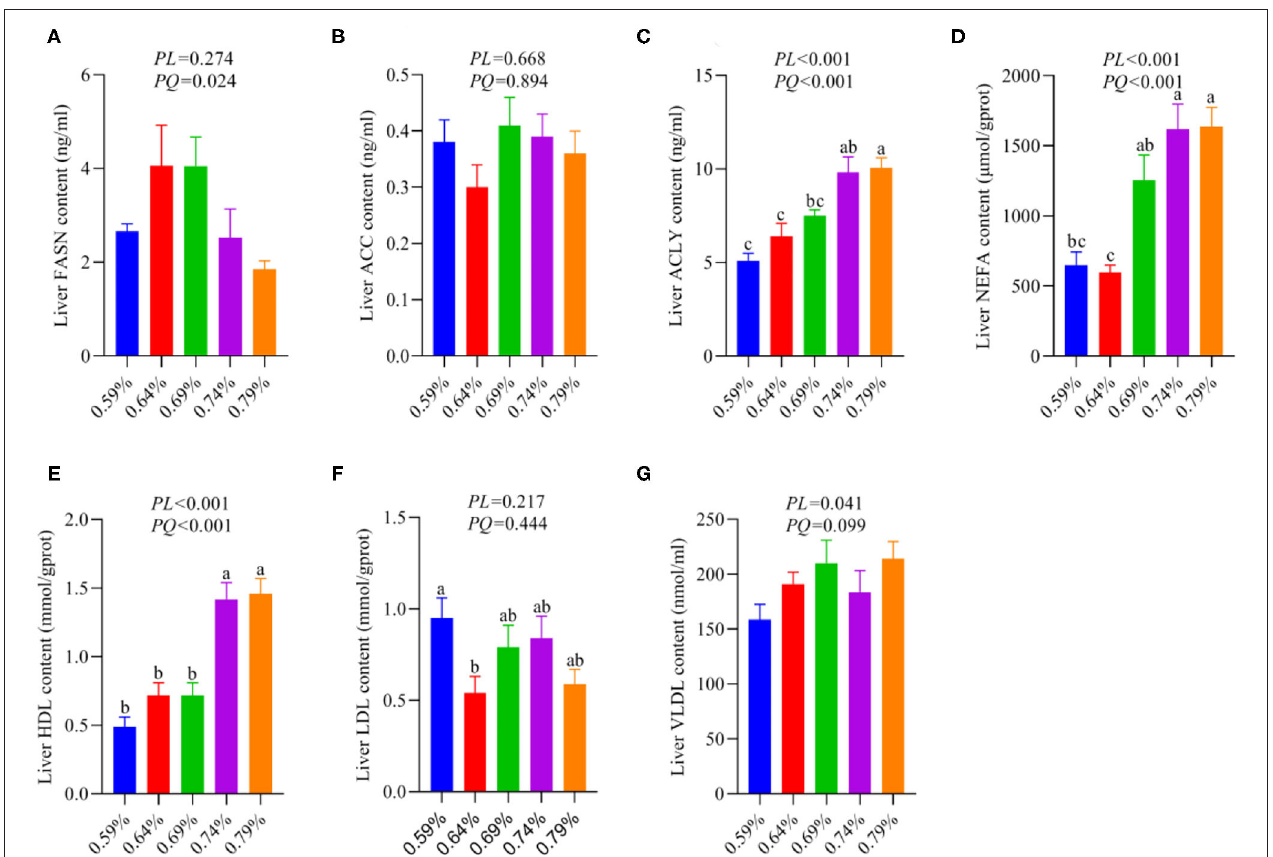
FIGURE 2 | Effects of dietary valine levels on liver lipid parameters ( n = 6–8). (A) FASN. (B) ACC. (C) ACLY. (D) NEFA. (E) HDL. (F) LDL. (G) VLDL. a − c Means with different superscripts within a column differ significantly ( P <